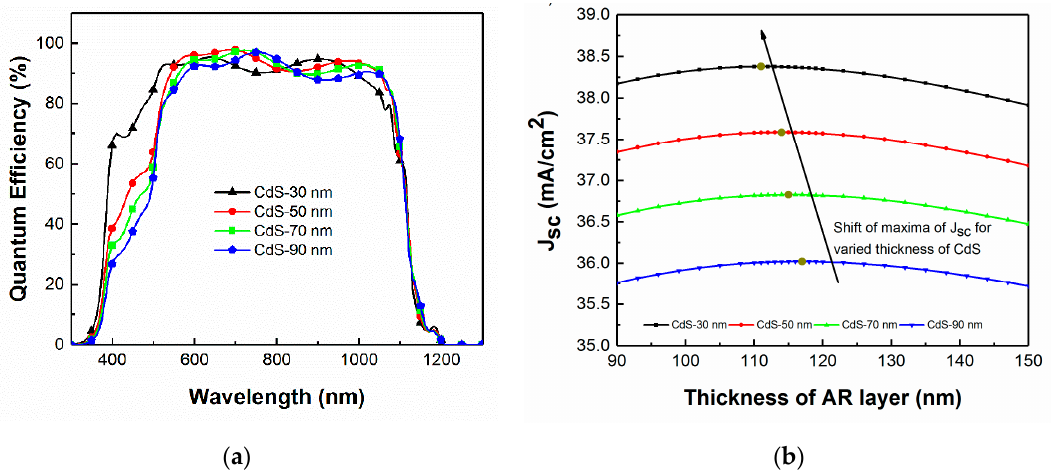
Figure 10. ( a ) Simulated QE with varied CdS layer thickness for a fixed 112 nm thick MgF 2 layer. ( b ) Simulated J SC as a function of MgF 2 thickness for various CdS thickness.